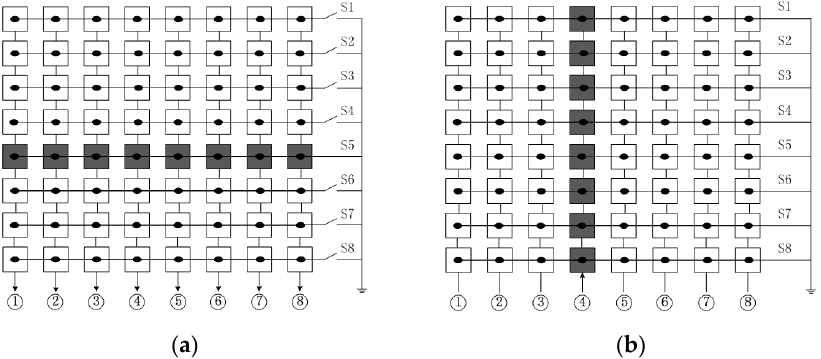
Figure 2. The transmit ( a ) and receive ( b ) activated elements indicated in the grey shading for an 8 × 8 array.